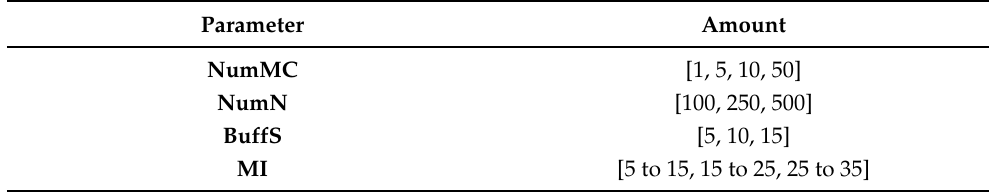
Table 1. Configuring the effective parameters ONE.